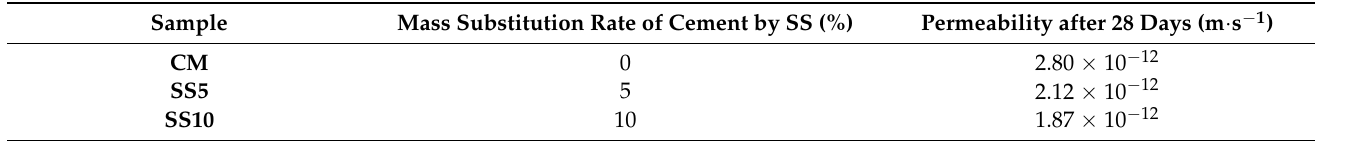
Table 7. Mortar composition and permeability after 28 days.